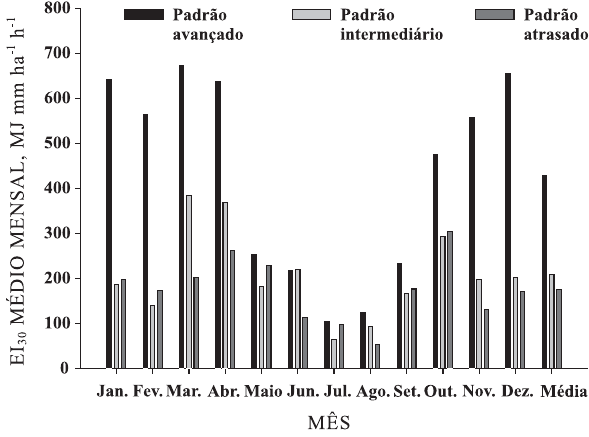
Figura 6. Distribuição da erosividade média mensal por padrões hidrológicos das chuvas erosivas de São Borja, RS, no período de 1956 a